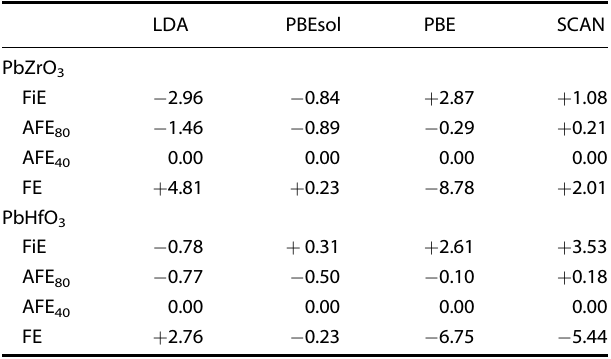
Table 1. Kohn – Sham energies in meV per formula unit (f.u.) of the studied phases in PbZrO 3 (above) and PbHfO 3 (below) relative to the AFE 40 phase.